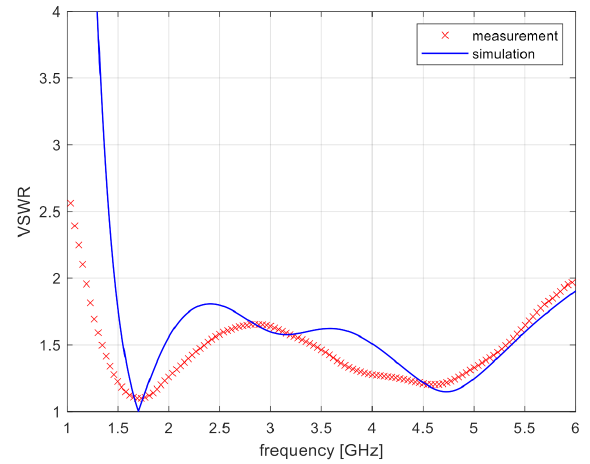
Figure 20. The impedance matching of prototype antenna for on-body location for 20 mm distance from the body.